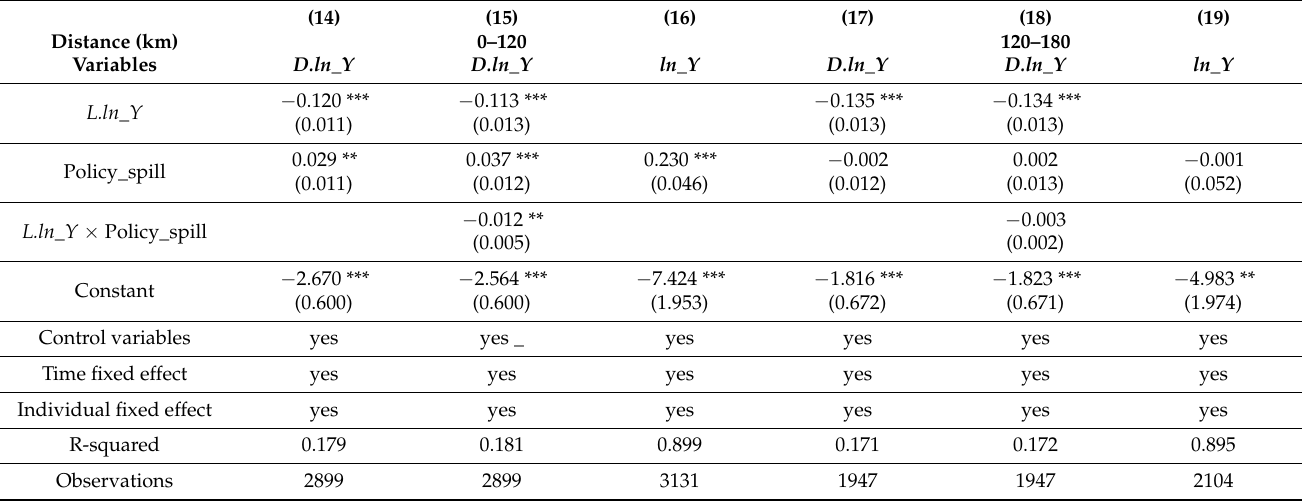
Table 3. The spatial spillover effect of the pilot policy (Plan